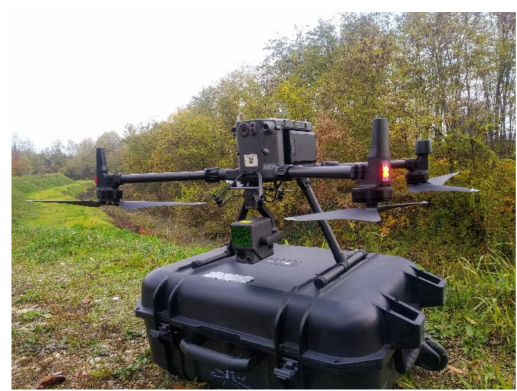
Figure 8. DJI Matrice 300 RTK with DJI Zenmuse L1